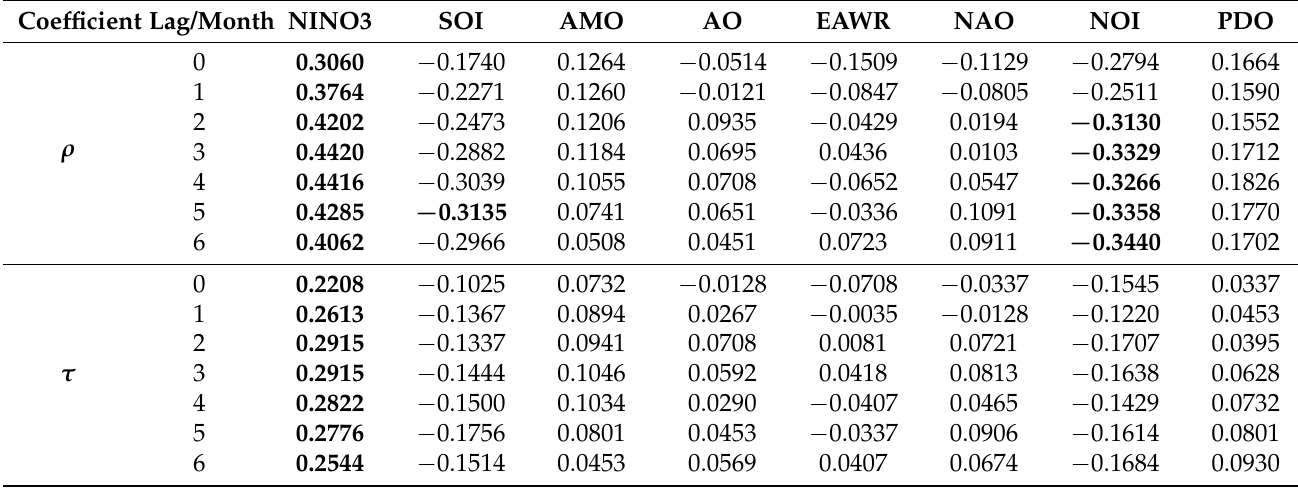
Figure A5. The correlations between the series of precipitation and ET 0 in JHP. Table A1. The Pearson correlation coefficient ρ and the Kendall correlation coefficient τ between the time series of annual precipitation and climate indices under lags from 0- to 6- month. Bold means statistically significant at the level of